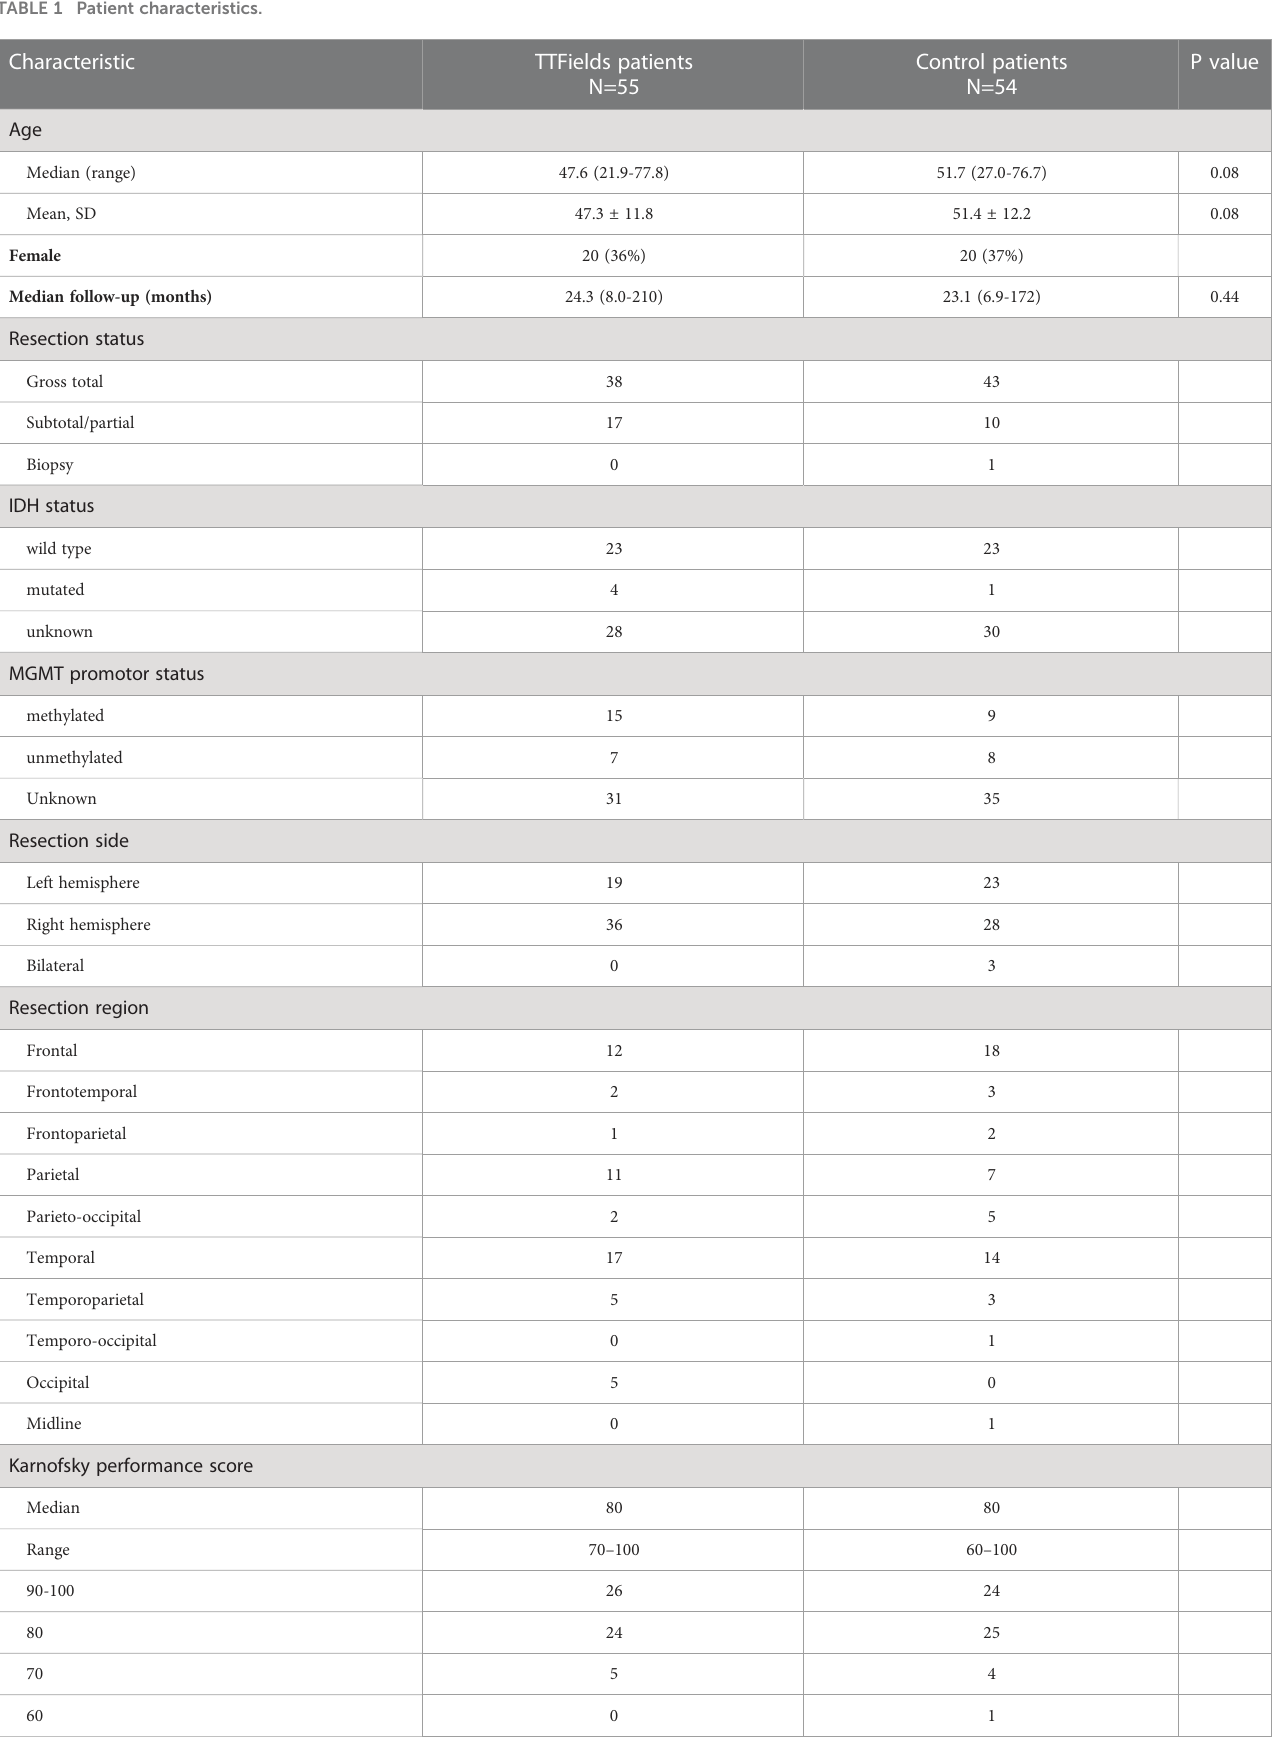
TABLE 1 Patient